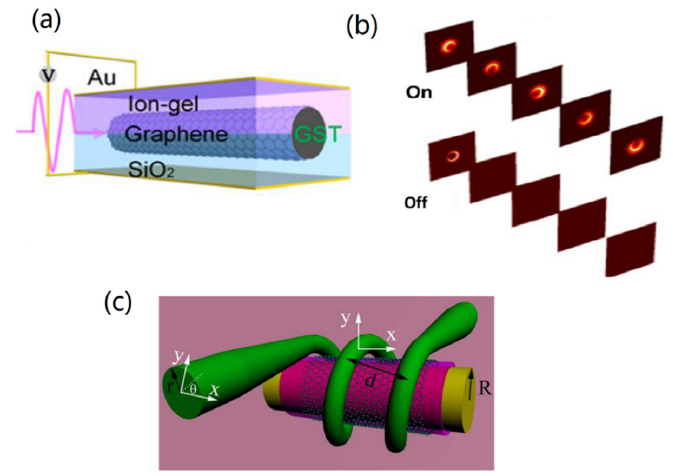
Figure 9. ( a ) Sketch of the graphene-coated GST225 nanowire and ( b ) switching “on/off“ chiral SP modes at µ c = 0.6 eV. Reprinted with permission from reference [101]. Copyright American Chemical Society, 2018. ( c ) Schematic of a graphene-based nanowire in-line polarizer with a two-coil structure. Reprinted with permission from reference [105]. Copyright Optical Society of America, 2014.